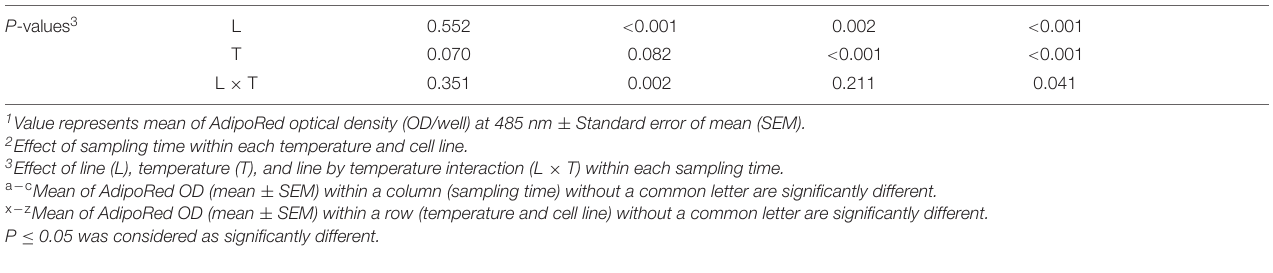
TABLE 4 | Effect of cold stress (33 ◦ C) on lipid accumulation during proliferation of satellite cells isolated from the pectoralis major muscle of Randombred Control Line 2 (RBC2) and Nicholas Commercial (NC) turkeys 1 . Line